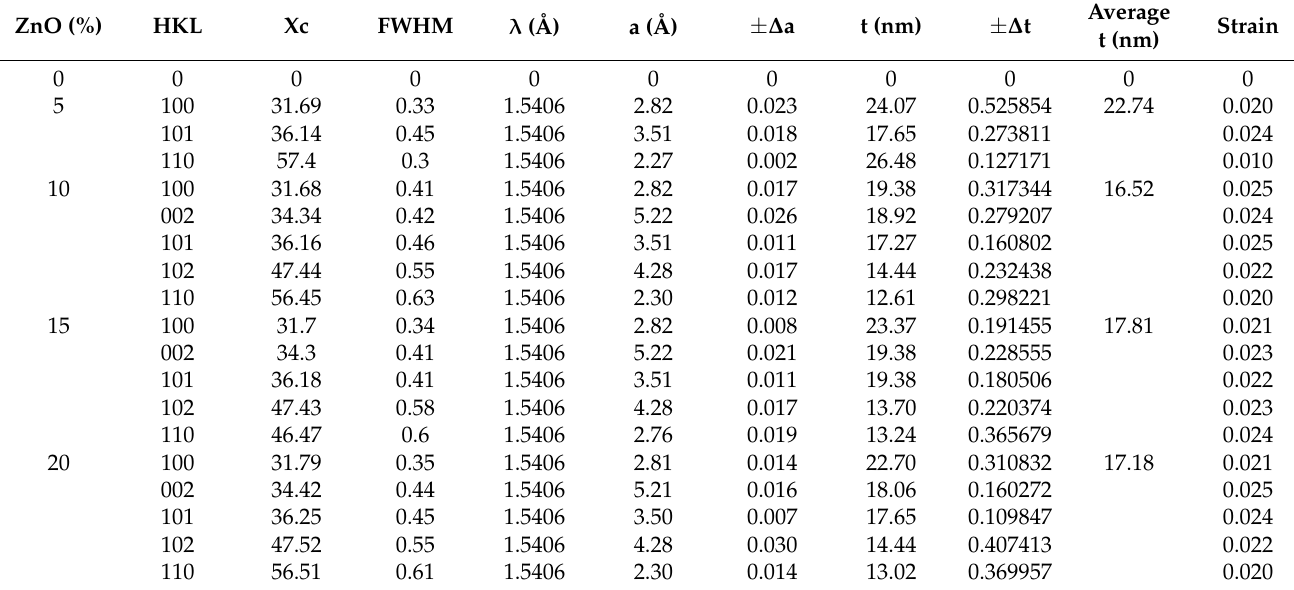
Table 3. Crystallite size and lattice